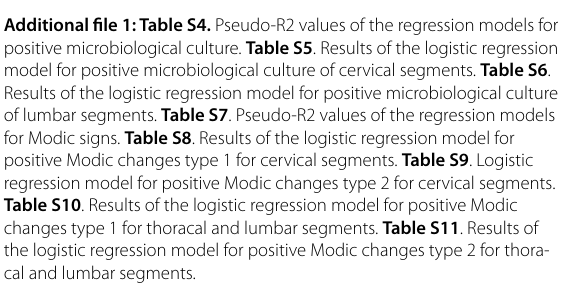
Table S10 . Results of the logistic regression model for positive Modic changes type 1 for thoracal and lumbar segments. Table S11 . Results